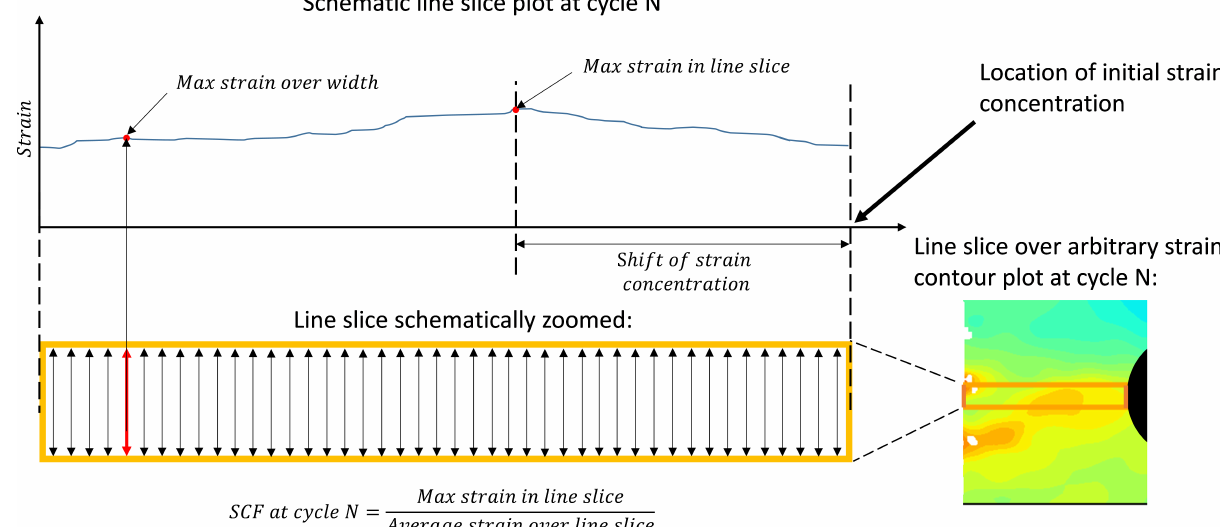
Figure 7: Schematic description of a line slice.